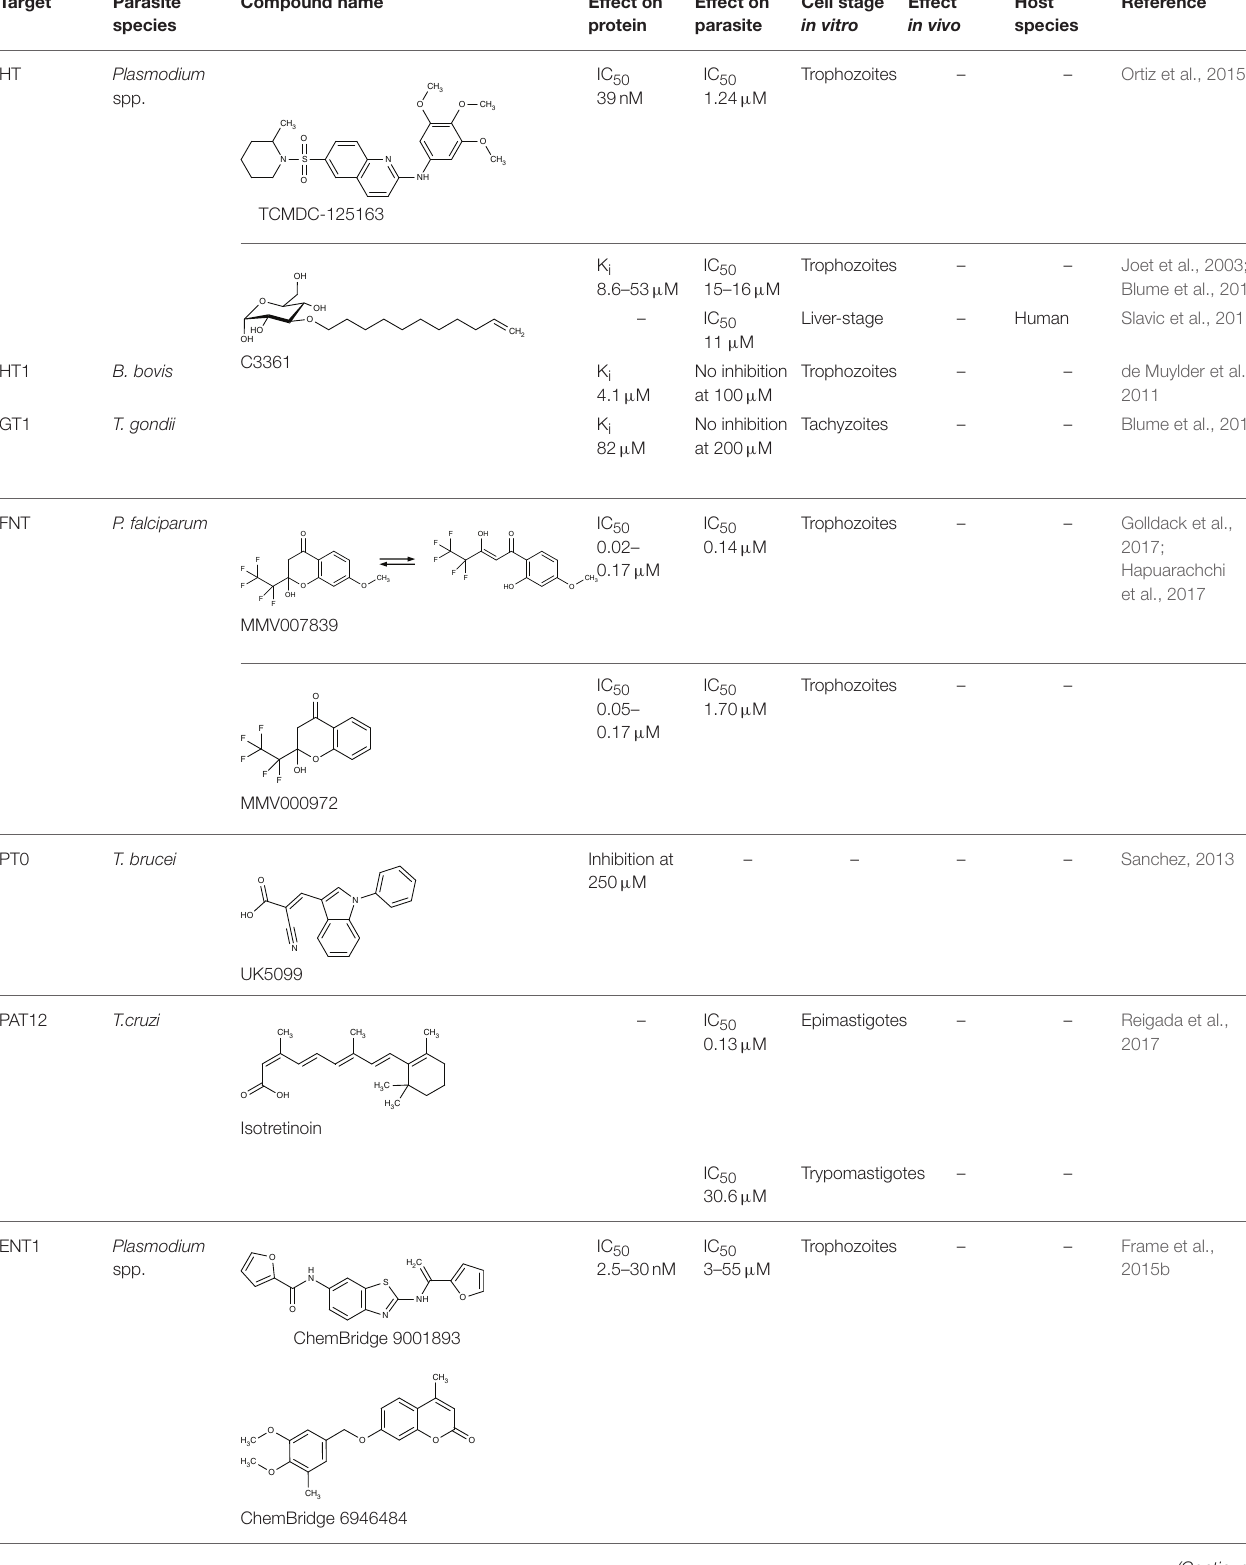
TABLE 2 | Efficiency of compounds for peripheral